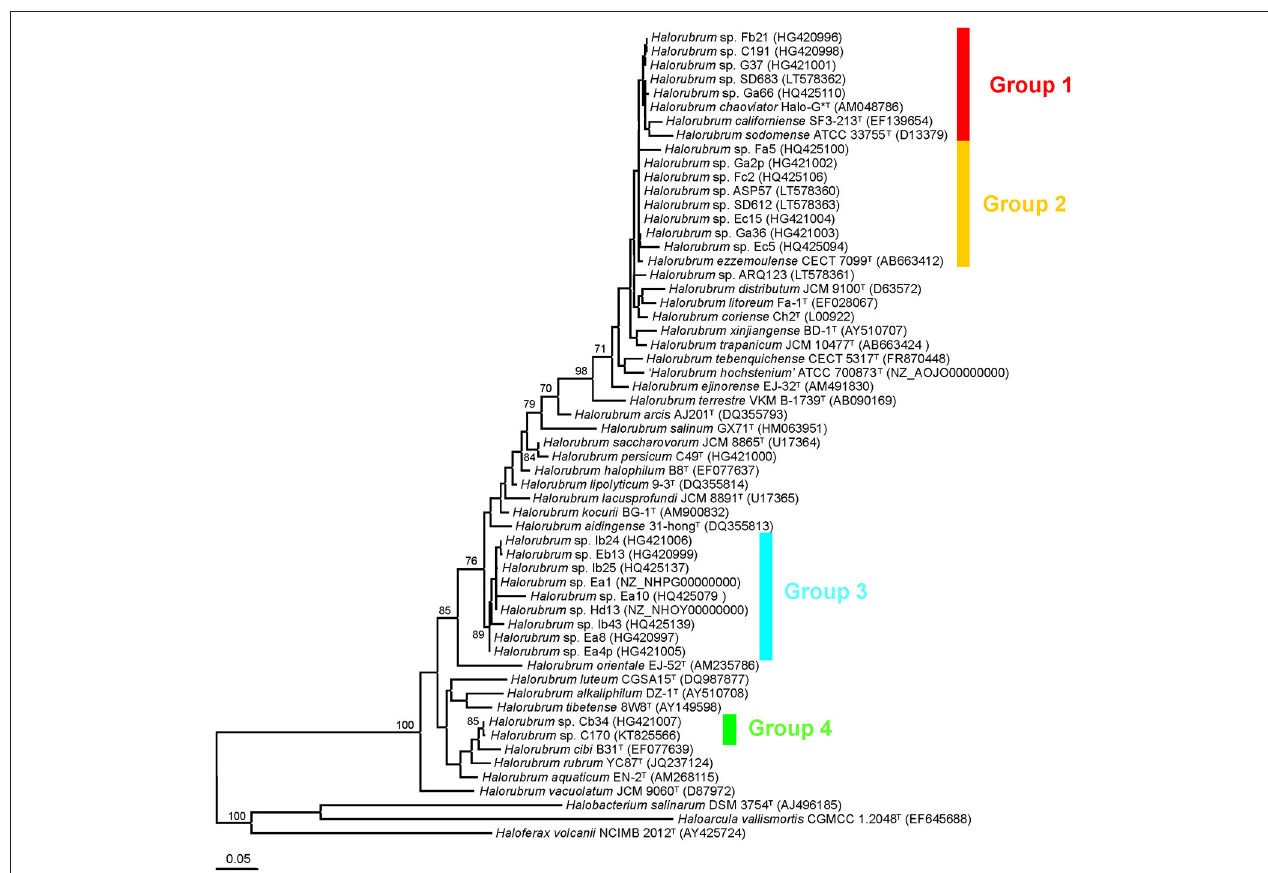
FIGURE 1 | Maximum-likelihood tree based on 16S rRNA gene sequence showing the phylogenetic relationship between members of the genus Halorubrum and strains isolated in this study. The accession numbers of the sequences used are shown in parentheses after the strain designation. Bootstrap values > 70% are indicated. The species Haloarcula vallismortis , Haloferax volcanii, and Halobacterium salinarum were used as outgroups. The scale bar represents 0.05 substitutions per nucleotide position. Different phylogroups have been marked with different